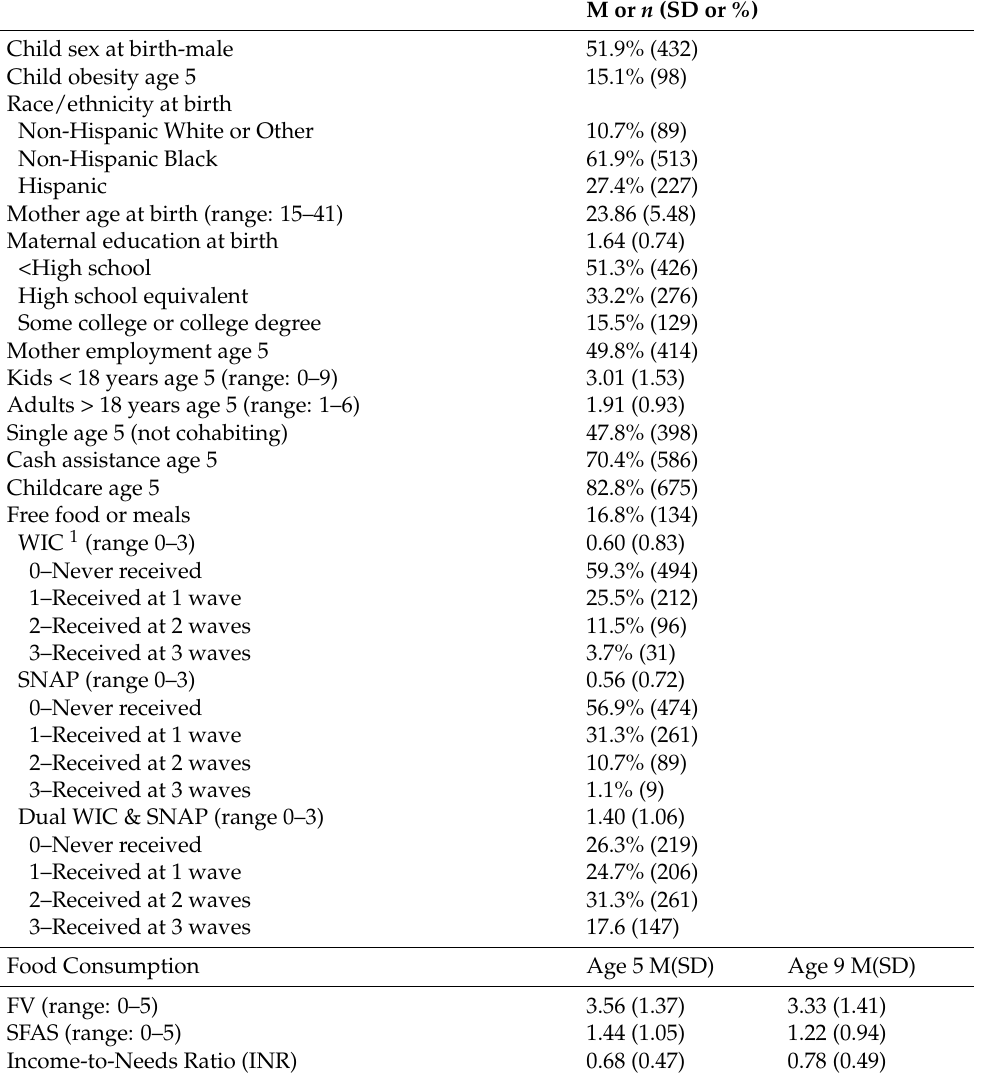
Table 1. Sample Characteristics and Descriptive Statistics ( n =